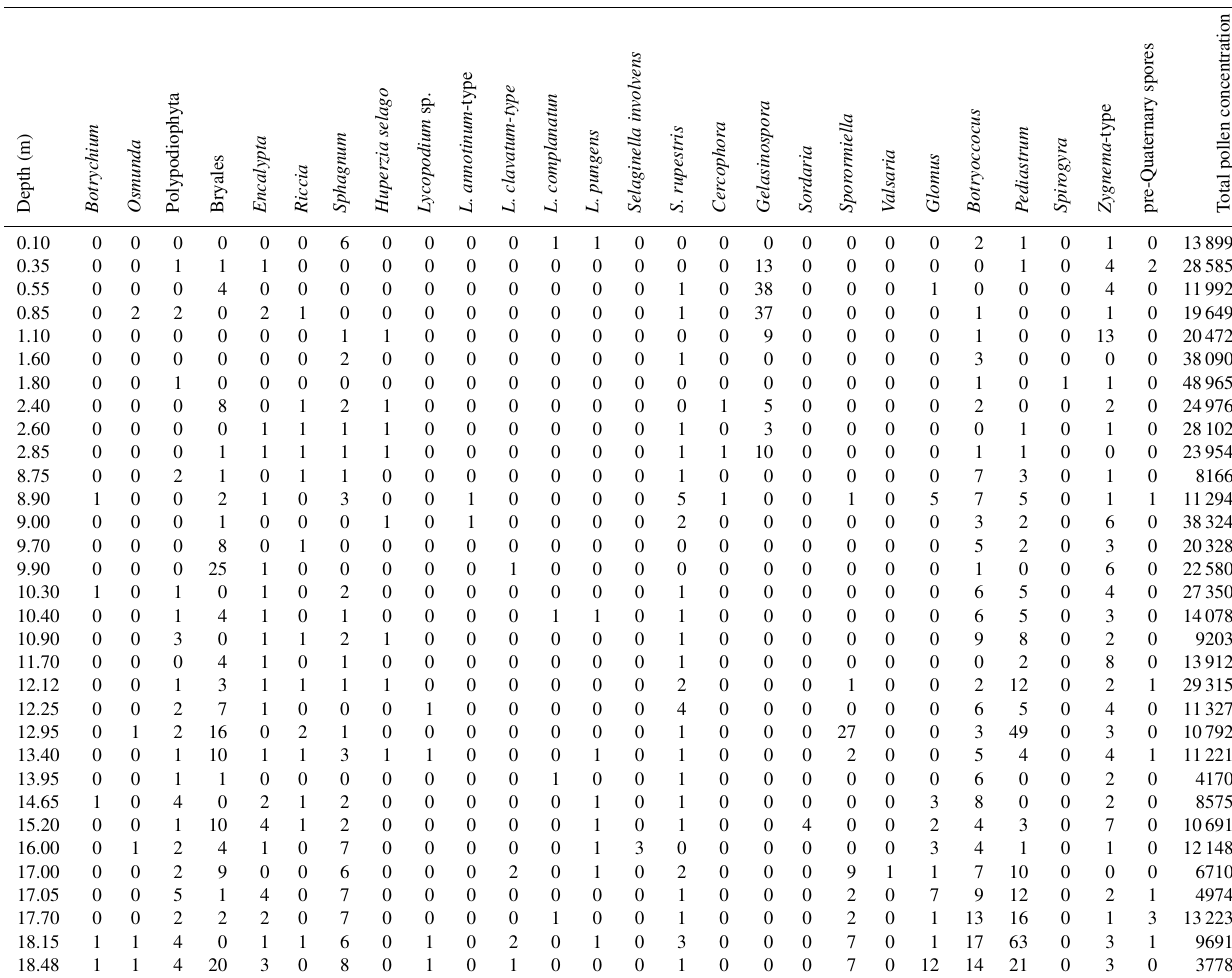
Table 3. Number of spores, algae, pre-Quaternary spores and total pollen concentration for each